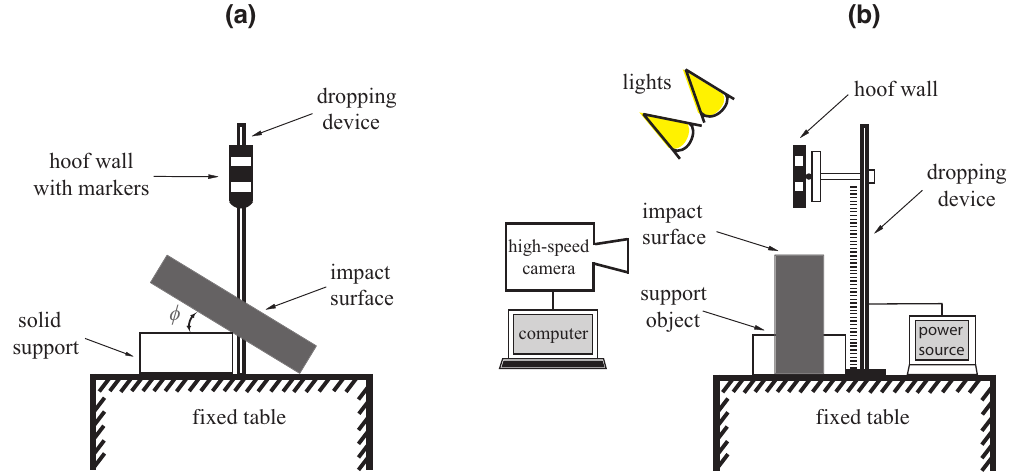
Figure 1. Sketch of the experiment setup ( a ) front view and ( b ) right